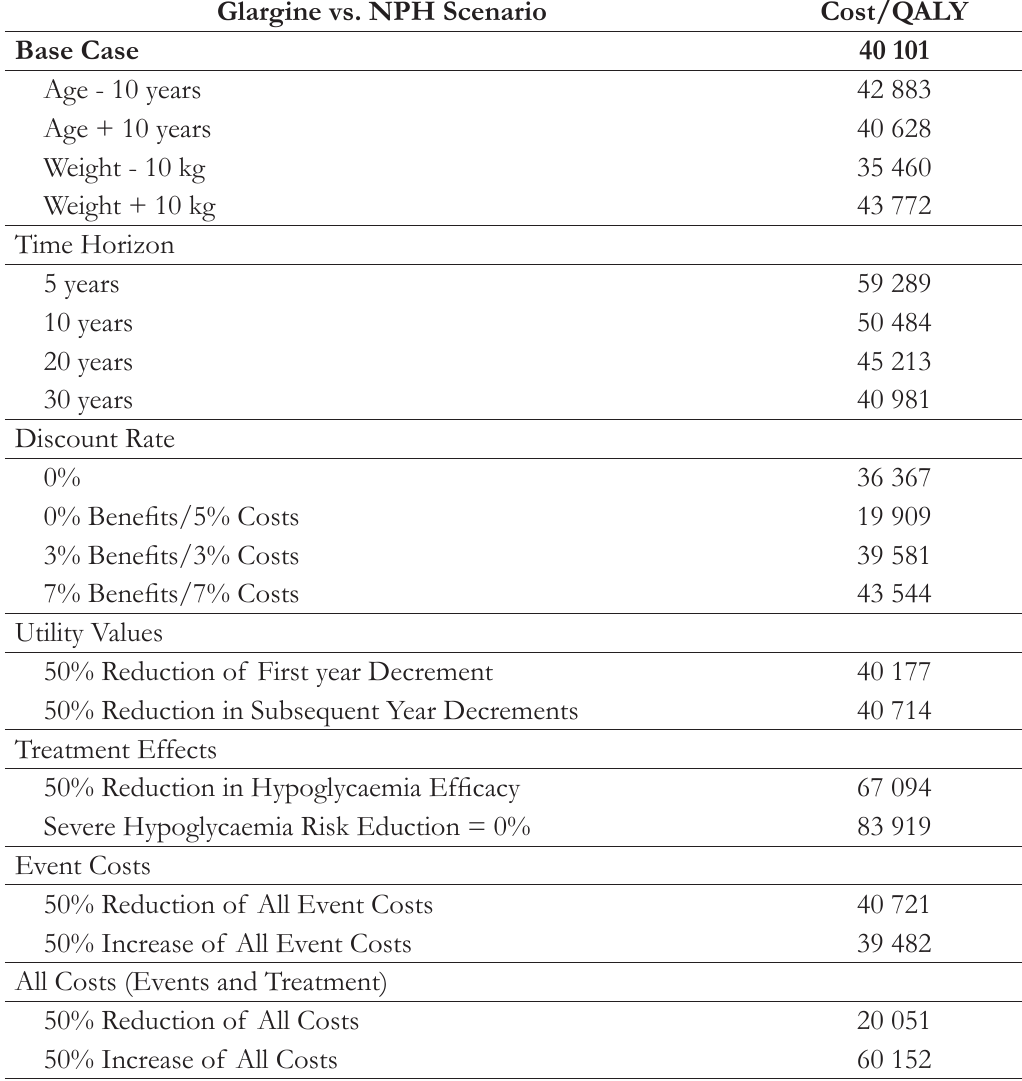
Table 7. Sensitivity Analysis on Key Model Parameters for Glargine versus